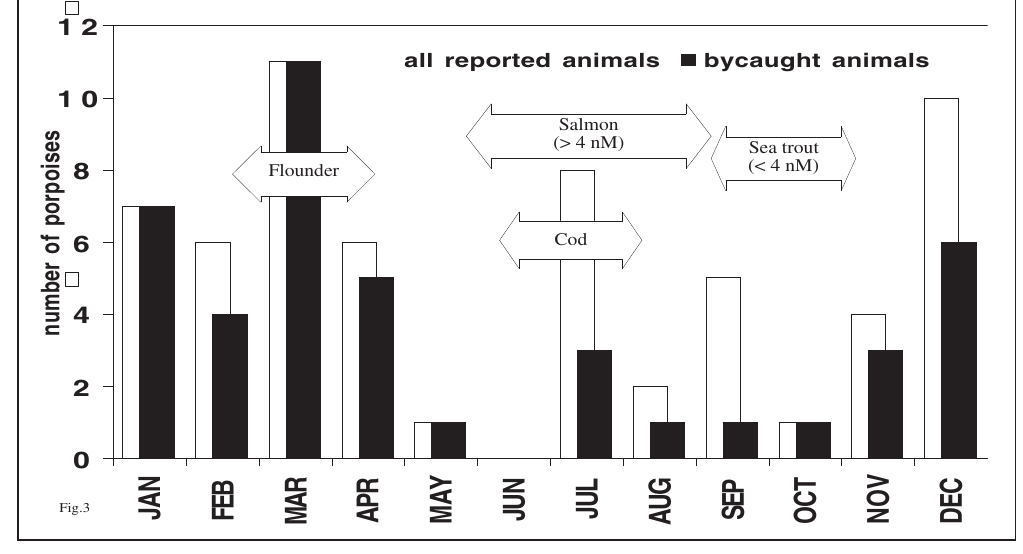
Fig. 2. Locations of sightings, bycatches and strandings of harbour por- poises on the Polish coast in the years 1990-1999. Geographical subregions of the coastal waters are according to Polish Sea Fishery